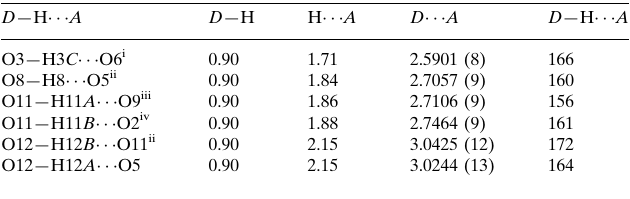
Hydrogen-bond geometry (A˚ , (cid:3) ). Cg 1 is the centroid of the N1/C2–C6